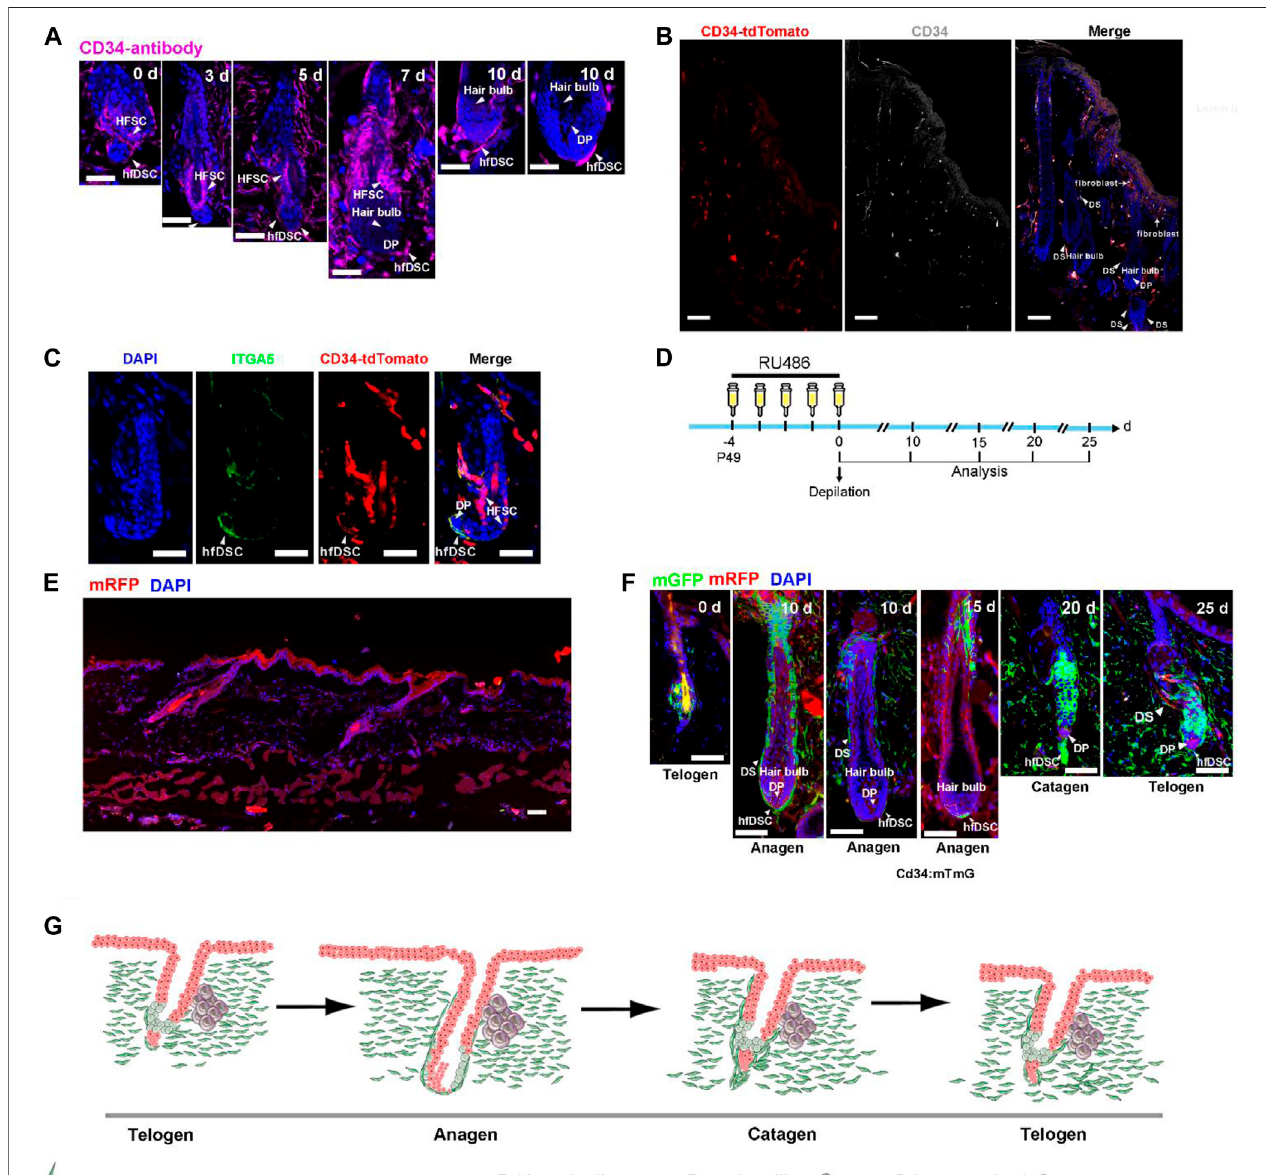
FIGURE1| CD34isexpressed inhfDSCs adjacent toDP and dermal fi broblasts. (A) Immunostaininganalysisfor CD34(purple) inskin tissues ofC57BL/6mice 0, 3, 5, 7and 10days after depilation. Arrowheads point toDS cells that express CD34. (B) Confocal microscope images of skin sections from CD34-tdTomato (red) mice immunolabeled with CD34 (white). Note the colocalization of tdTomato with CD34 in DS and fi broblasts. (C) Immuno fl uorescence analysis of a telogen HF from CD34- tdTomato (red) mice immunolabeled with ITGA5 (green). (D) Experimental scheme for RU486 injection and analysis of HFs at different stages of the depilation- induced hair cycle in CD34:mTmG mice. (E) Images of skin sections harvested from CD34:mTmG without RU486 injection. (F) Representative images showing the fate ofCD34-lineage cells(green) ateach stage ofthe fi rst depilation-induced haircyclein7-week-oldCD34:mTmG mice. (G) The schematic illustrating thetracingofCD34- lineage cells (green) during the fi rst depilation-induced hair cycle. Scale bars, 50 μ m.